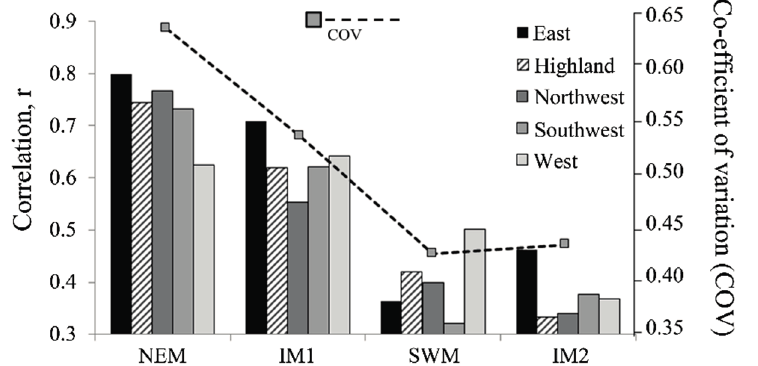
Figure 4. Seasonal correlation of the TRMM 3B43 against ground rainfall at local climate region of Peninsular Malaysia. The line represents the co-efficient of variation (COV) of areal rainfall